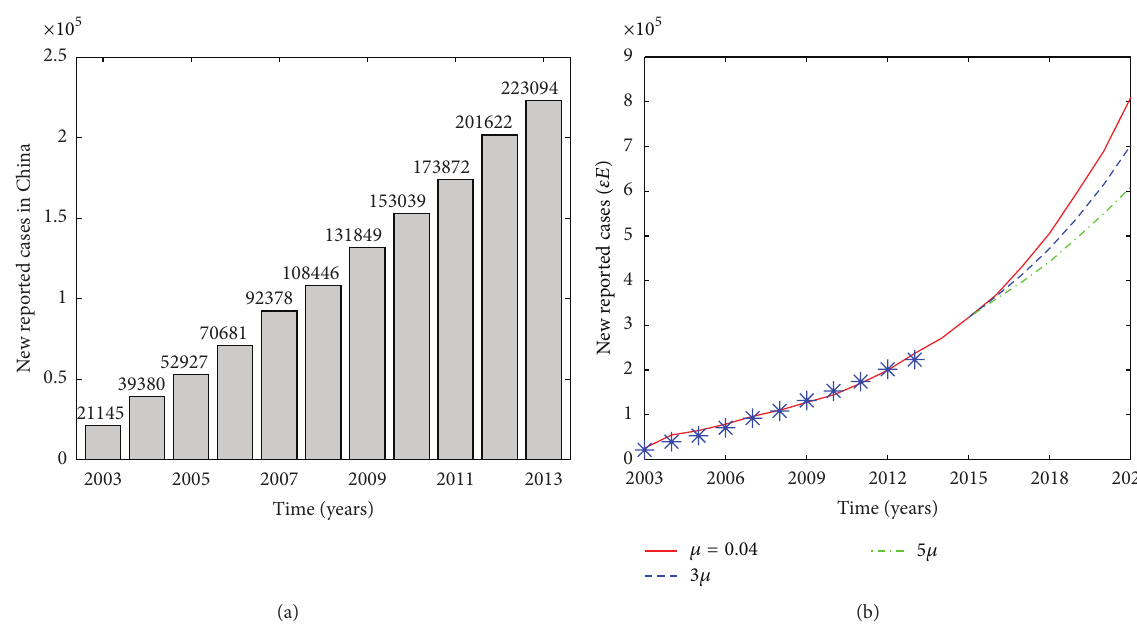
Figure 2: (a) Annual newly reported HCV cases for mainland China; (b) goodness of fit and prediction of HCV trends until 2021. Stars represent the reported number of people with HCV by year. The solid line shows the fit based on the current circumstances ( 𝜇 = 0.04 ). The dashed and dash dot lines show the prediction at higher treatment rates 𝜇 = 0.12 and 𝜇 = 0.2 for patients at the chronic stage from 2015, respectively. All the other parameters are as shown in Table